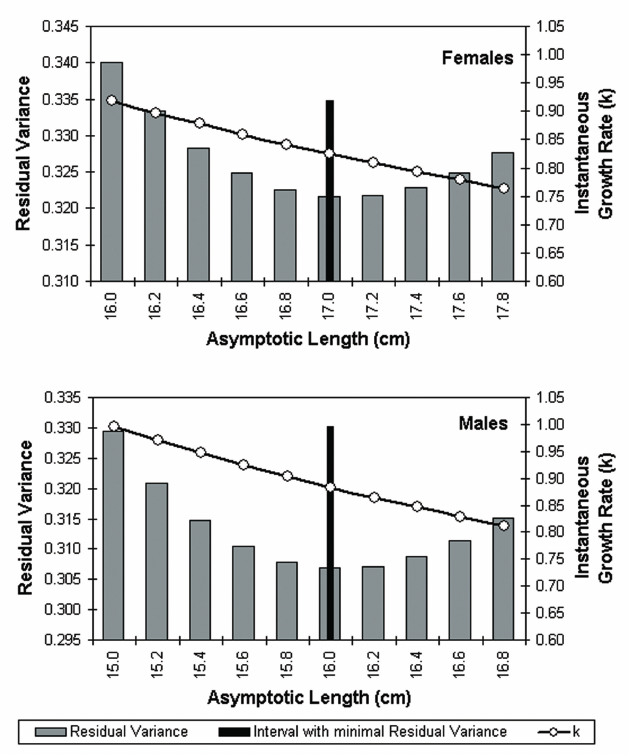
Fig. 4 . Minivar plots to estimate growth parameters of the von Bertalanffy growth function for the silverside Atherinella brasiliensis in Tramandaí Estuary, Southern Brazil.